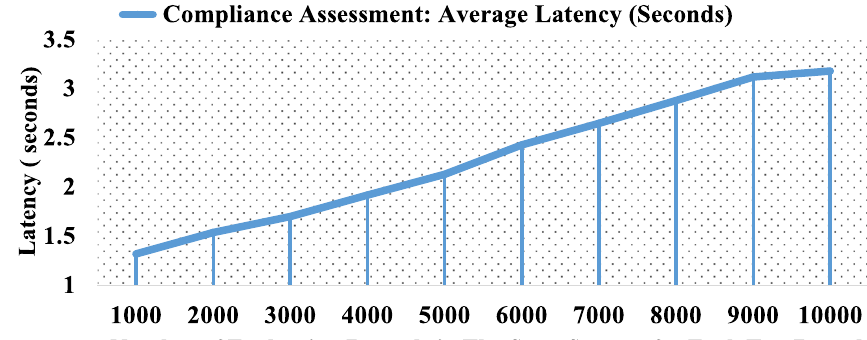
Fig. 17 Latency for executing Algorithm 3 on variable collection of evaluation records stored on HLF state